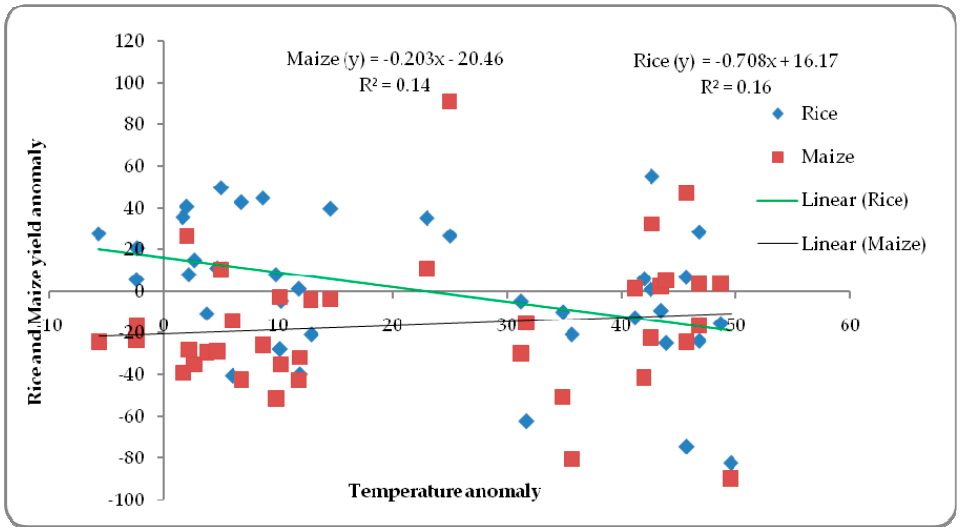
Figure 5. Correlation coefficients (r) values for rice and maize yield, along with temperature anomaly.